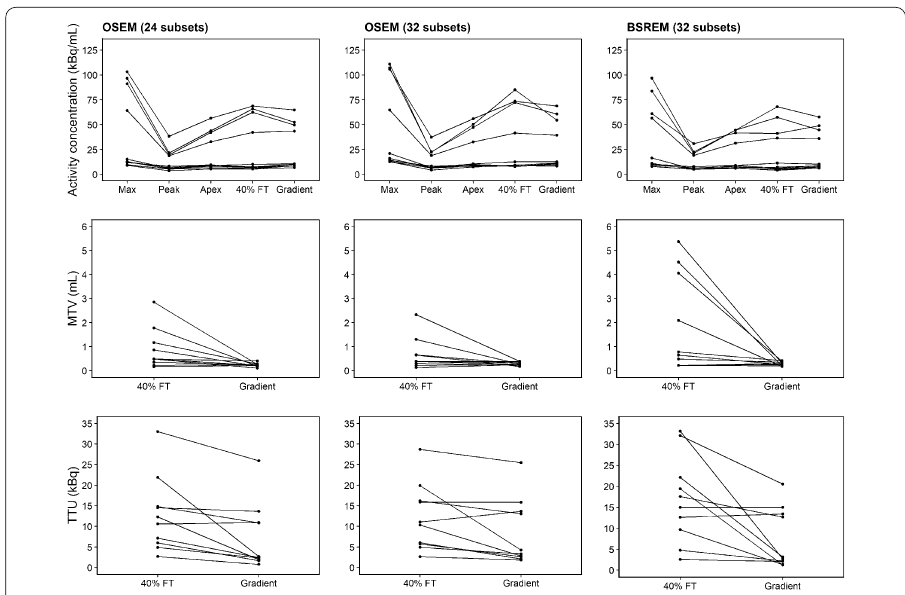
Fig. 12 Lesion activity concentration, volume, and uptake determined from patient analysis. Activity concentration plotted using max, peak, apex, mean (40% FT and gradient) metrics (top), metabolic tumour volume; MTV using 40% FT and gradient segmentation (middle row), and total tumour uptake; TTU using 40% FT and gradient segmentation (bottom) for ten lesions from [ 18 F]DCFPyL patient images